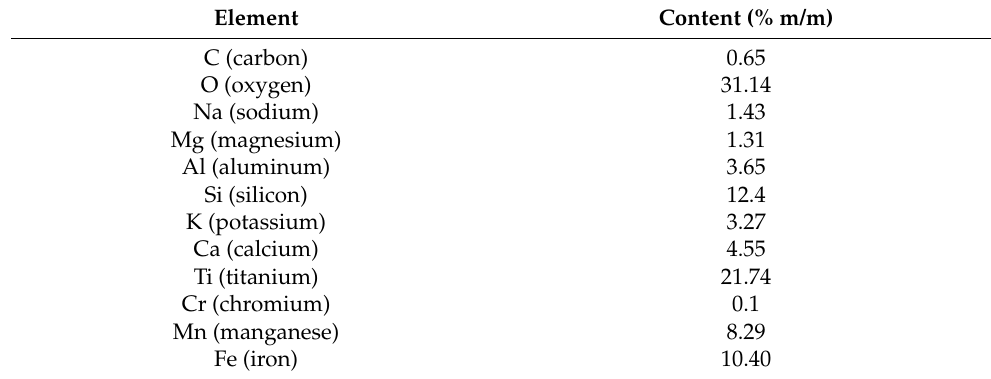
Table 3. The chemical composition of the sample taken from the handy-size bulk carrier 30206 DWT. X-ray